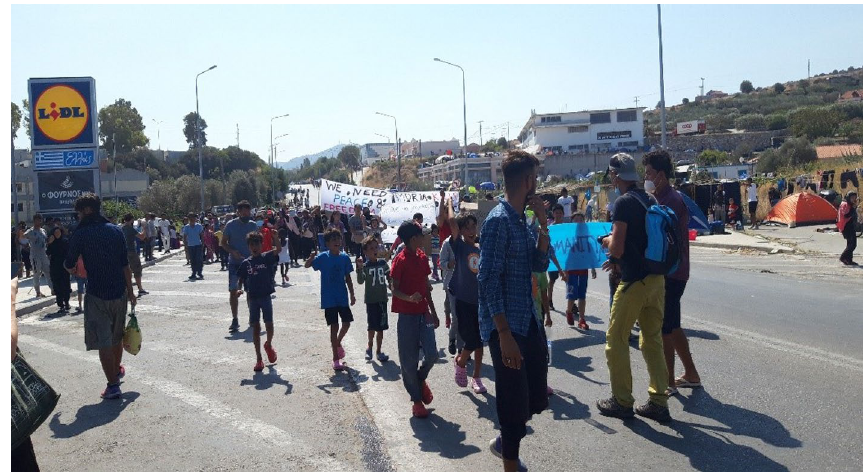
Fig. 2 Former camp habitants of Moria protesting on the streets near Kara Tepe; Copyright and photo: Claudia Böhme